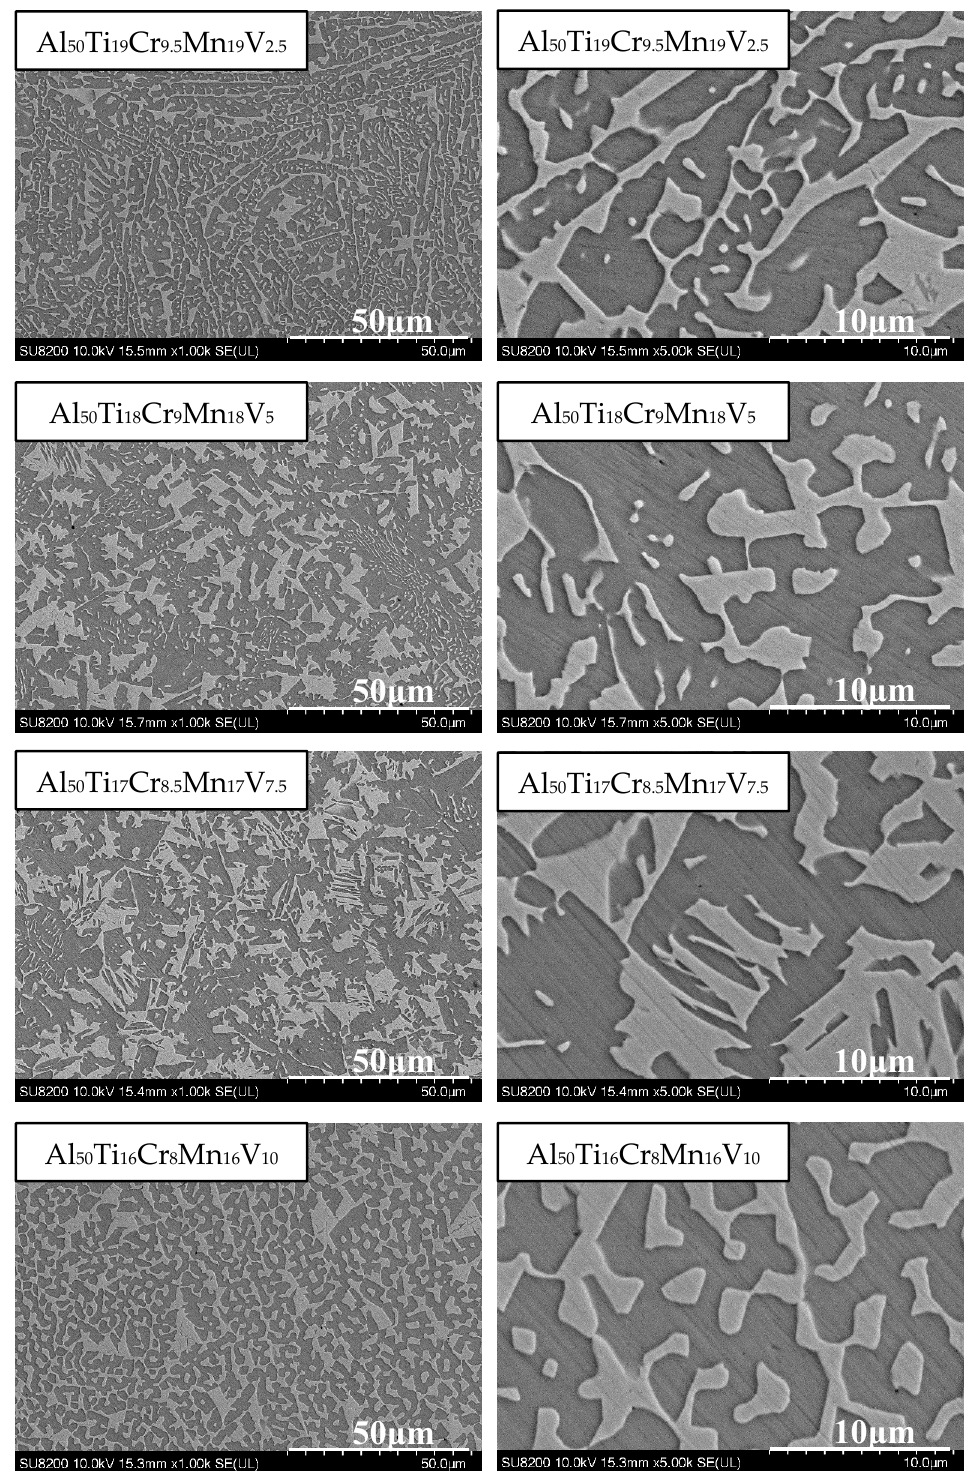
Figure 9. SEM images of the Al 50 (Ti 2 Cr 1 Mn 2 ) 50-x V x (x = 2.5, 5, 7.5, 10) alloys. 3.4. Al 50 Ti 20 Cr 10 Mn 20-x V x Series To further promote the mechanical properties of the Al 50 –Ti–Cr–Mn–V alloy, an alloy system of Al 50 Ti 20 Cr 10 Mn 20-x V x (x = 2.5, 5, 7.5, 10) was designed. A high content of Ti im- proved the toughness, and maintaining a certain content of Cr strengthened the alloy.